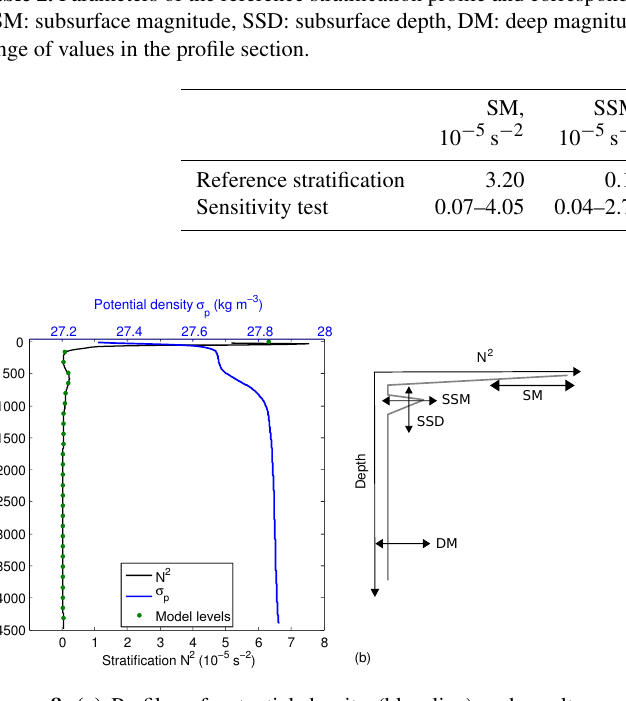
Figure 8. (a) Profiles of potential density (blue line) and result- ing stratification (“reference stratification”, black line) from historic CTD data obtained in January and February in the area of moorings M1 to M5, merged with profiles from the deeper Weddell Sea at depth. Green markers indicate the vertical levels of the numerical code. (b) Sketch showing the parameters changed in the stratifica- tion sensitivity tests. Arrows indicate direction (but not magnitude) of changes. SM: surface magnitude, SSM: subsurface magnitude, SSD: subsurface depth, DM: deep